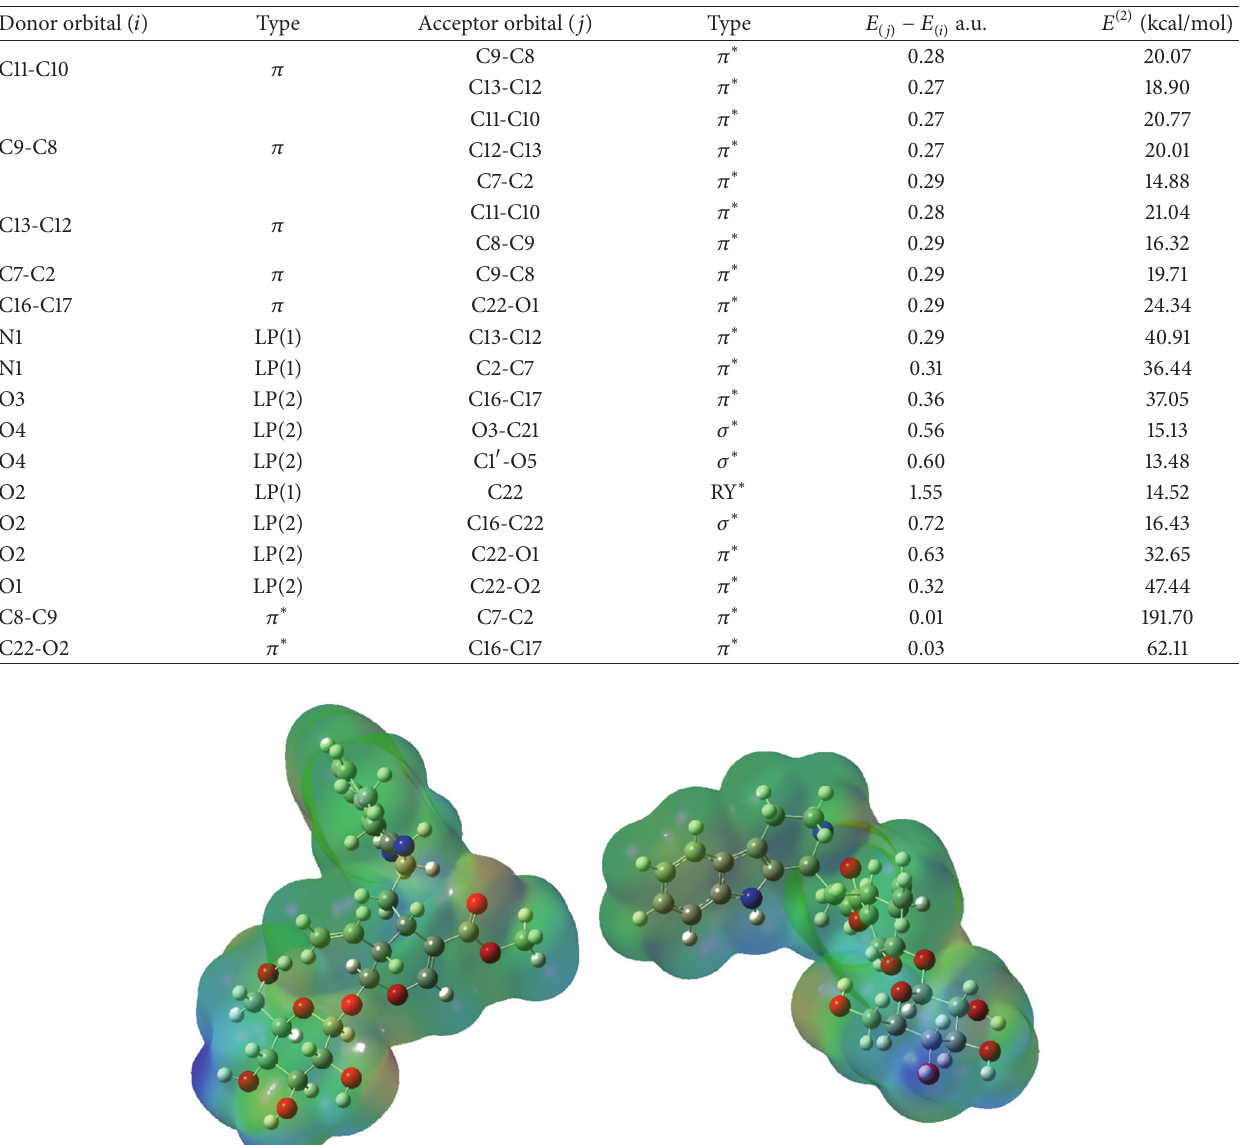
Table 4: Selected second-order perturbation energies for strictosidine.